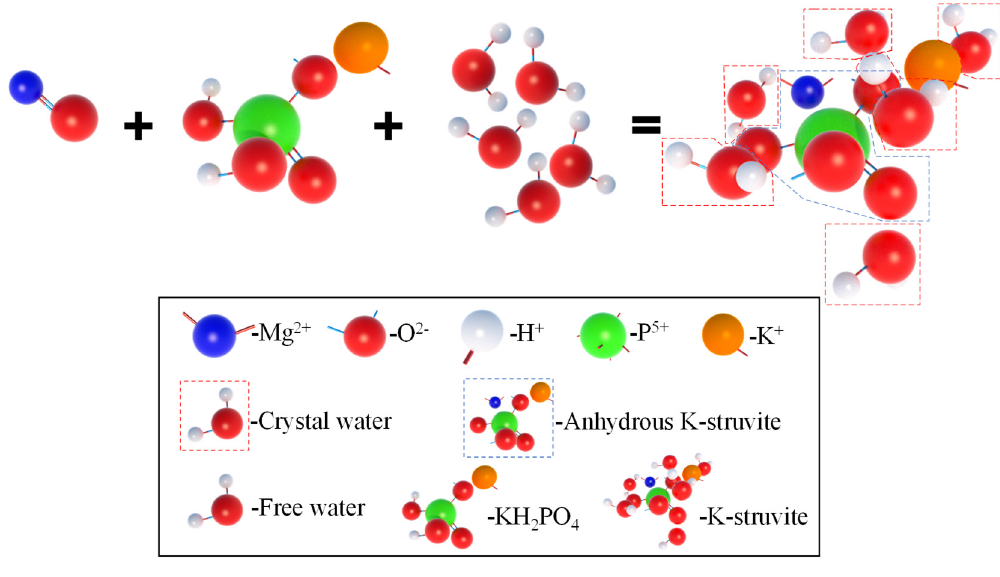
Figure 12. X-ray diffraction ( XRD) analysis of specimens. ( a ) T7; ( b ) T14; ( c ) T28.